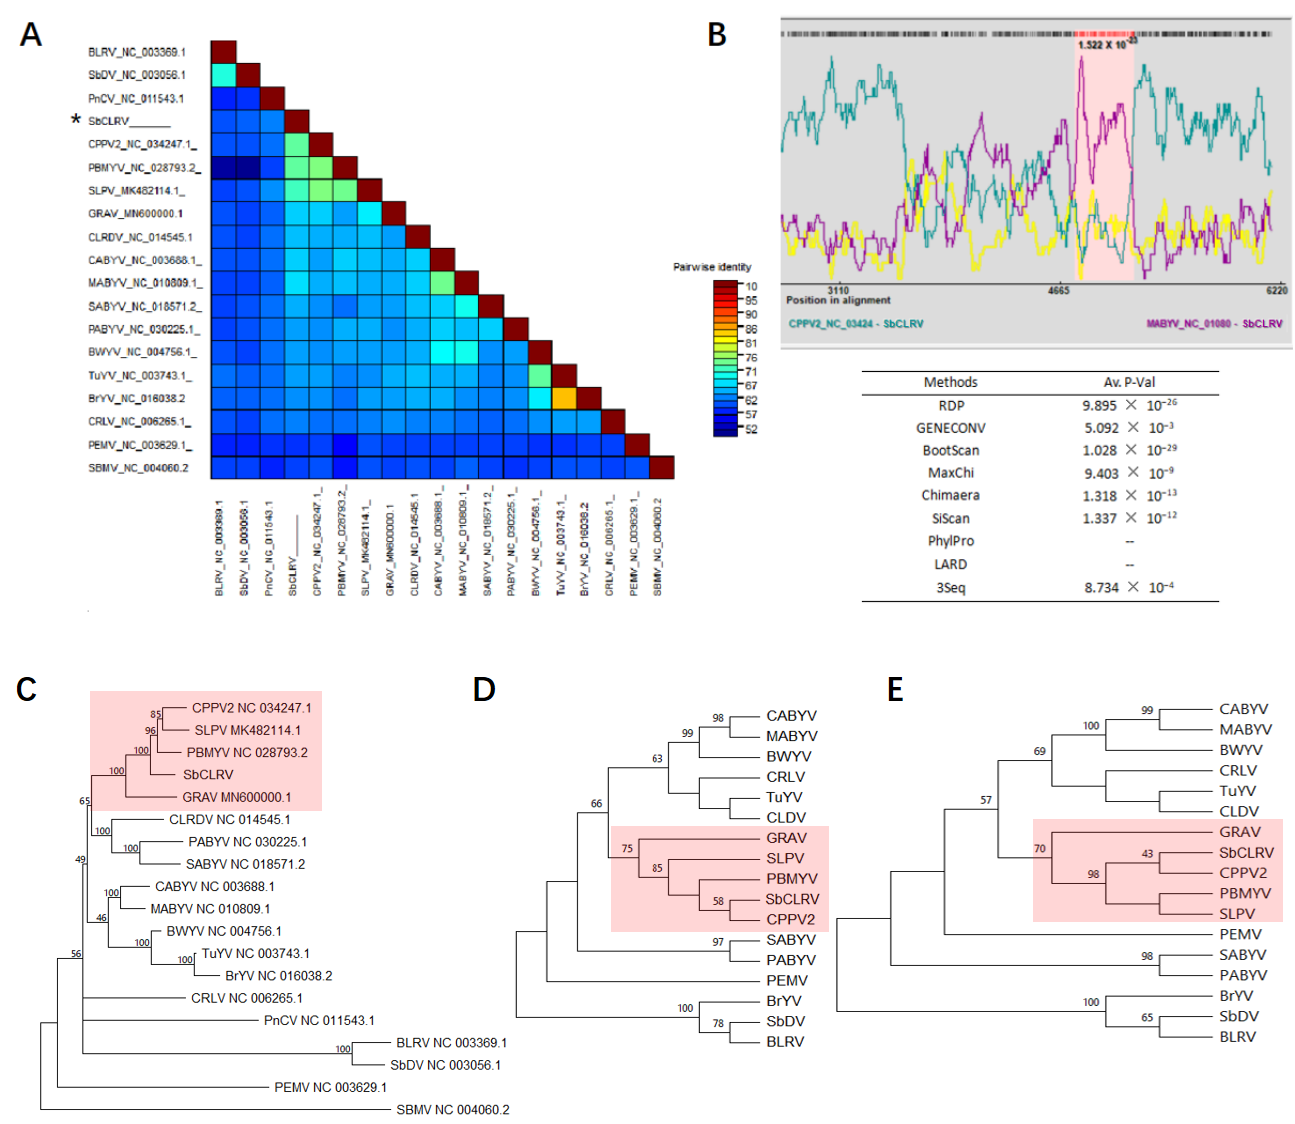
Figure 2. Phylogenetic analyses of the soybean chlorotic leafroll virus (SbCLRV) and selected members of the family Solemoviridae. ( A ) The pairwise identities plot of complete genomic nucleotide sequences aligned by MAFFT and displayed by sequence demarcation tool (SDT) software; ( B ) RDP3 analysis on the recombination event of these members. The peaks in pink zone represent the recombination events of SbCLRV with melon aphid-borne yellows virus and cotton leafroll dwarf virus in positions 5337 – 5578 nt and 5034 – 5255 nt, respectively; phylogenetic analyses of selected viruses based on the nucleotide sequences of ( C ) complete genome (model GTR + G + I) and amino acid sequences of the proteins ( D ) P1 – P2 (RdRp) (model WAG + G) and ( E ) P3 (CP) (model JTT +